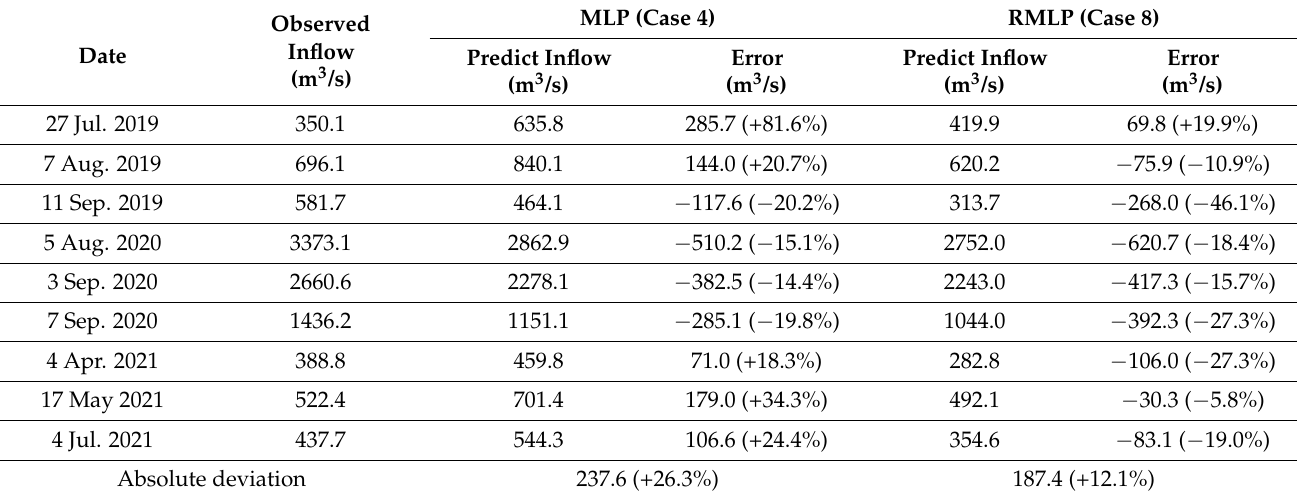
Table 9. Peak discharge error